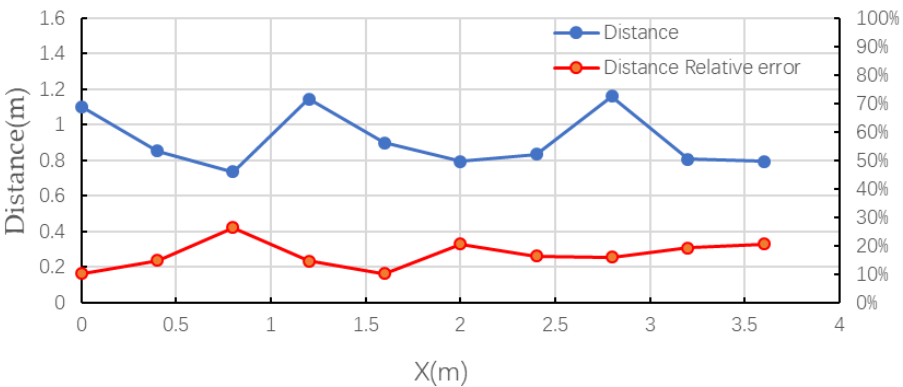
Figure 26. Sensor array to transmission line distance curve.